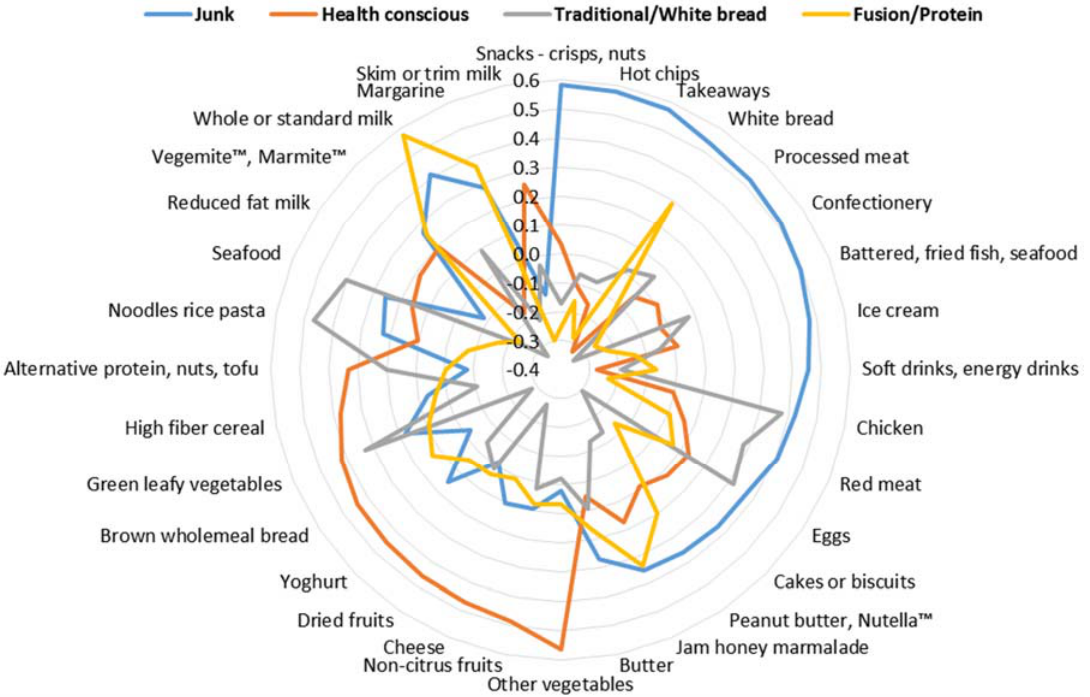
Figure 1. Factor loadings after varimax rotation on identified dietary patterns of food groups retained. Not shown are food items with values less than 0.3 (fruit juices, other cereal, citrus fruits, butter and margarine blend, high fibre white bread, processed fish, other bread, other milk, plant sterol margarine, soy milk, lite or reduced fat margarine, soft drinks sugar free).